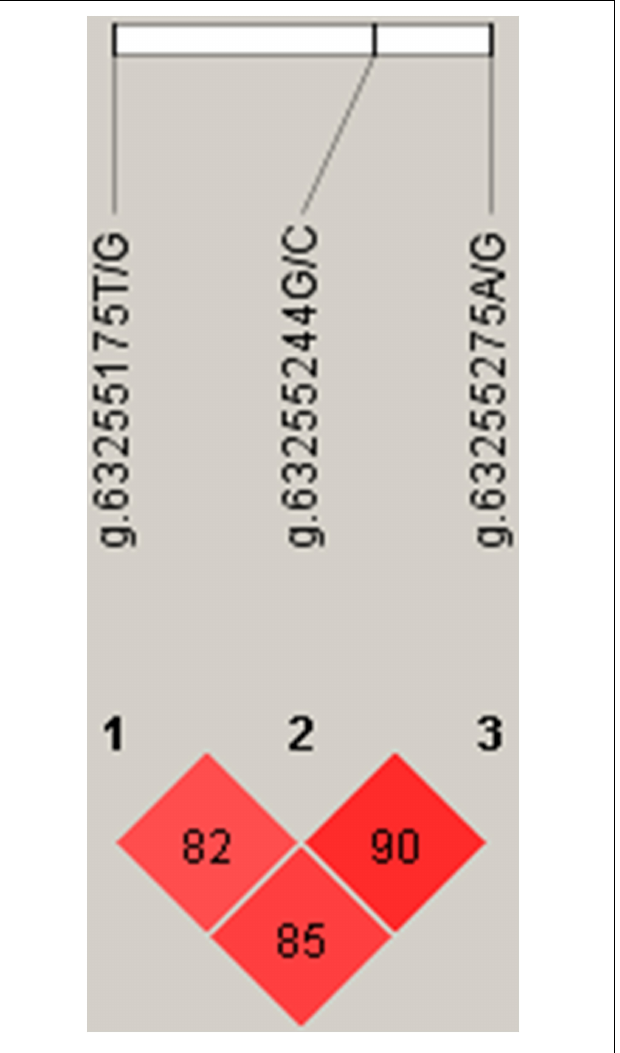
TABLE 3 | Association analysis between haplotypes and body height of Hu sheep.